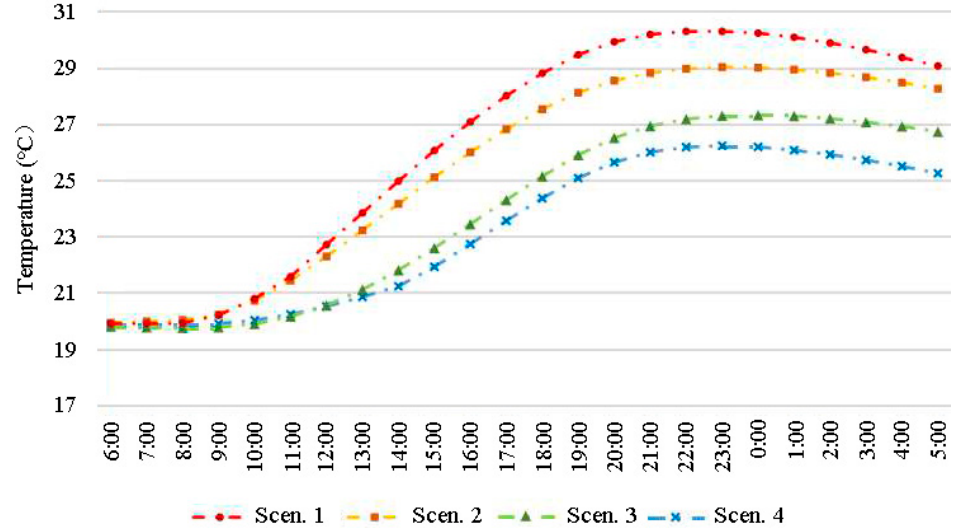
Figure 9. Air temperature inside of four scenarios in the day.